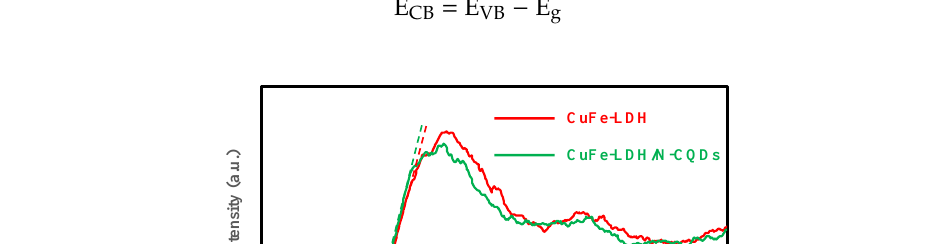
Figure 9. UV-vis diffuse reflectance (DRS) ( a ) and calculated band gap (E g ) ( b ) for CuFe-LDH and CuFe-LDH/N-CQDs.